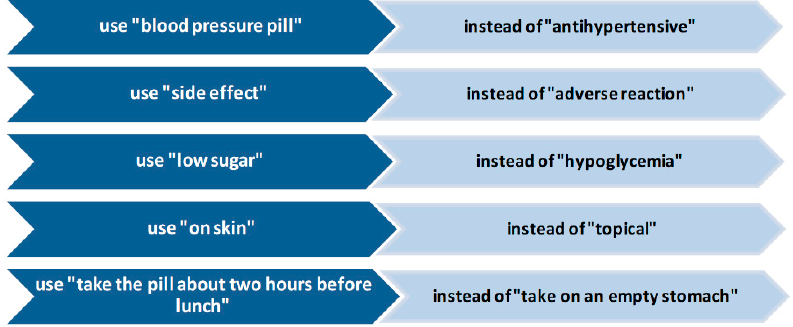
Figure 3. What a pharmacist could say instead of using medical terminology [62].